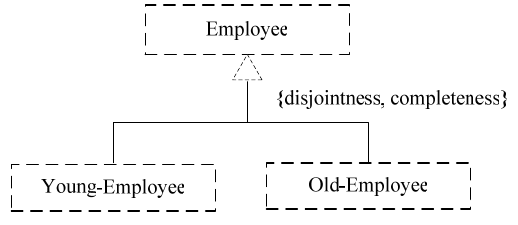
Fig. 1. Representation of a fuzzy class Old-Employee in a fuzzy UML model.